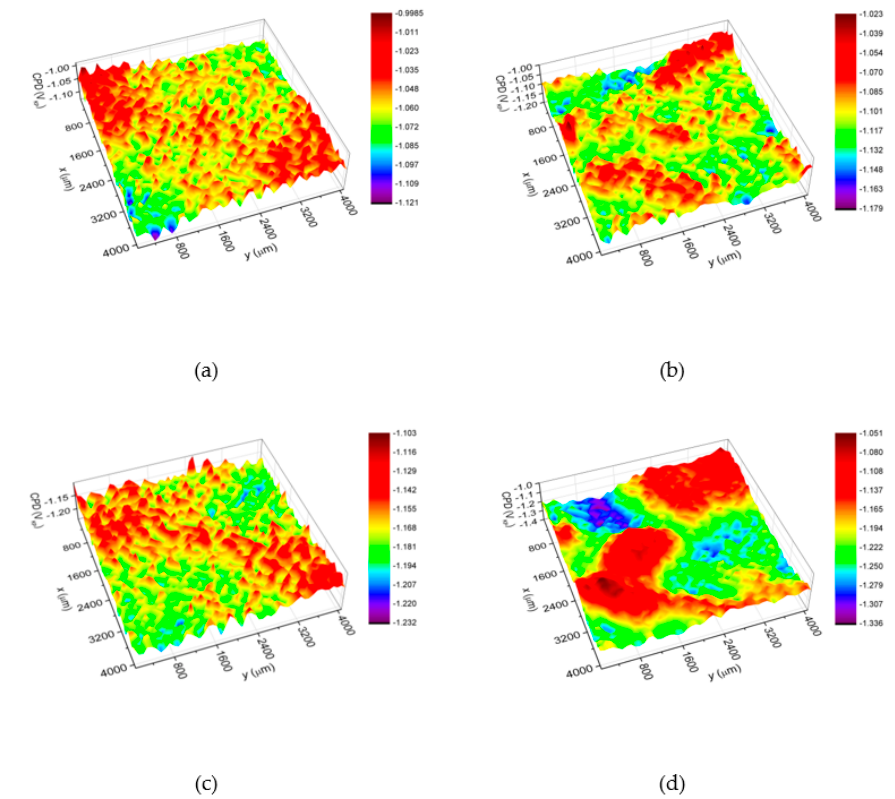
Figure 6. CPD maps determined for the Ni-W coatings after heat treatment in the air: ( a ) C125 / 1173, ( b ) C150 / 1173, ( c ) C175 / 1173 and ( d ) C200 / 1173. Table 4. Statistical parameters obtained using CPD maps of the heat-treated Ni-W coatings. Ni-W Coating C125 /